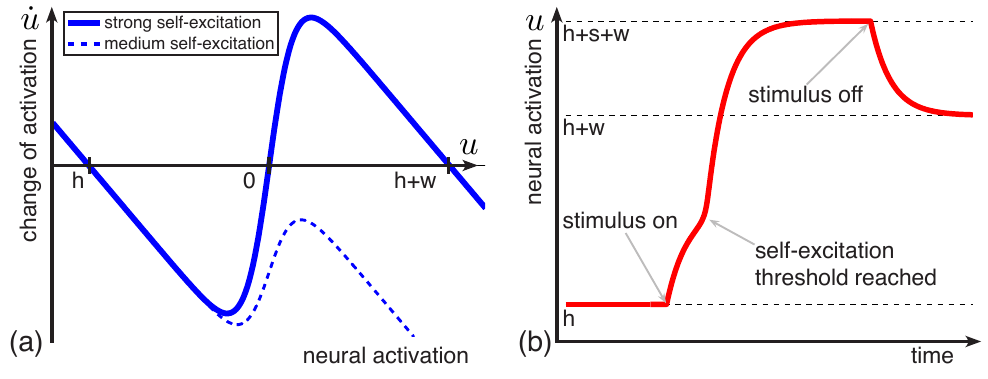
Figure 10: Dynamics of a single neuron with strong self-excitation (Equation 12). Panel (a) shows the phase plot (solid) without external stimulus, for comparison the phase plot of the same system with medium self-excitation is repeated (dashed). Panel (b) shows an example trajectory for a case in which the stimulus is turned on and off again.